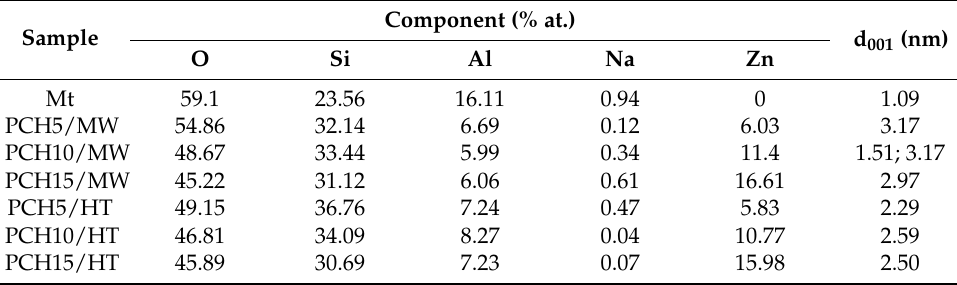
Figure 3. SEM images of ZnO 2 /SiO 2 ‐ PCH samples. Table 1. Elemental analysis and d 001 of ZnO 2 /SiO 2 -PCH materials in comparison with Mt.